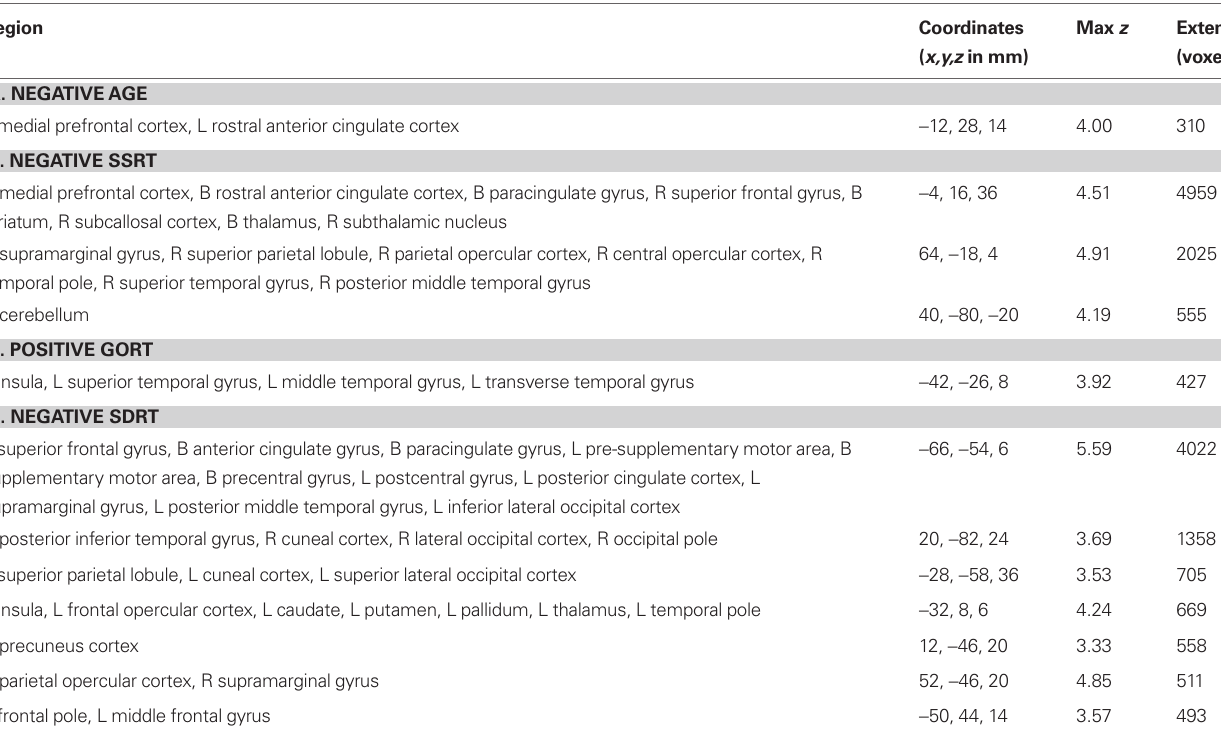
Table 4 | Clusters of activity associated with correlations between successful stopping vs. successful going and (A) age, (B) SSRT, (C) median Go response time (GoRT) and (D) the standard deviation of Go response time (SDRT). Region Coordinates